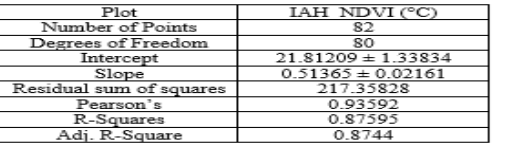
Table 3. Scattered plots of (a) IAH (b) NDVI and (c) IAE map generated from Landsat-8 data acquired on the 10 th and IAH vs IAE